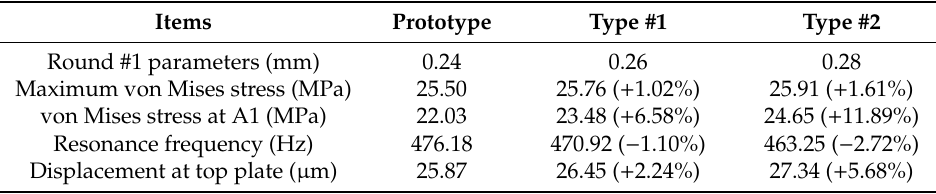
Figure 18. von Mises stress distribution on spring with different round #1 parameters. Table 3. Analysis result comparison between different round #1 parameters.